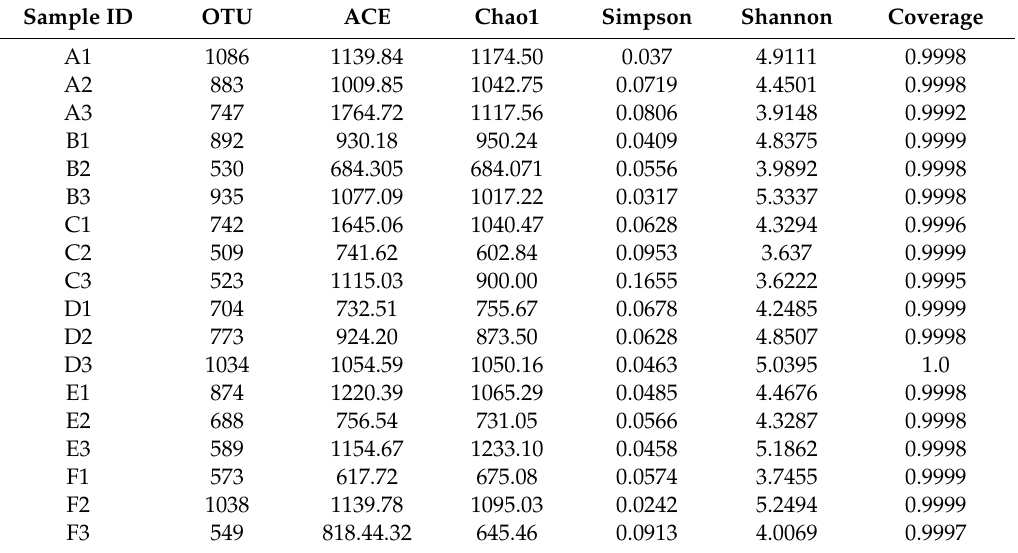
Table 3. The diversity of C. camphora